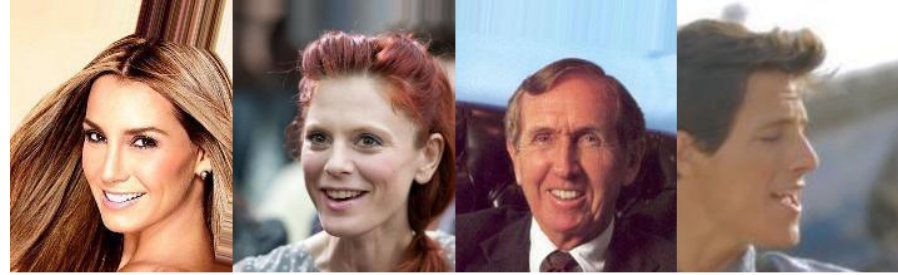
Figure 2. Example images taken from the CelebA dataset